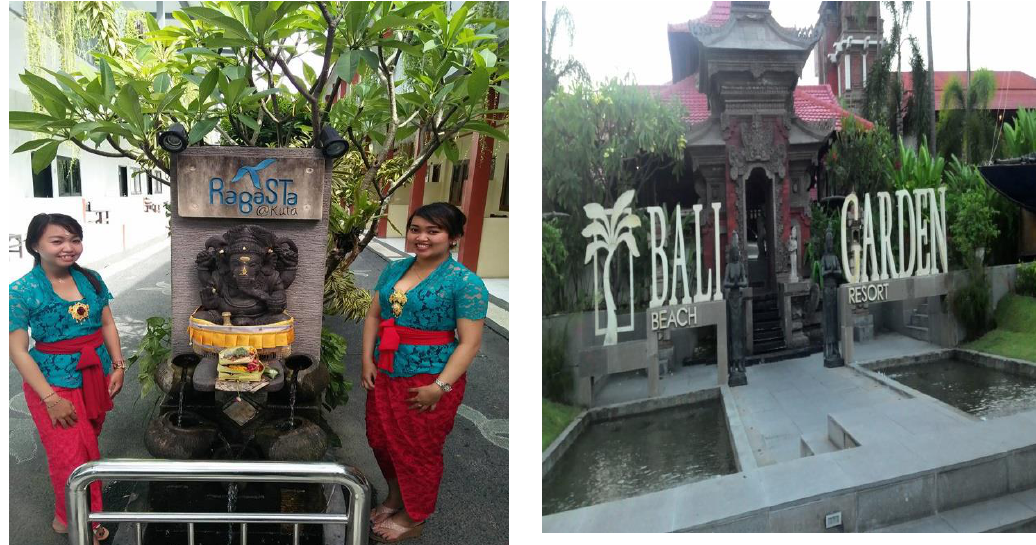
Fig. 1: Vernacular in the tourism industry (shrines, costumes and architectures) Source: Mulyawan